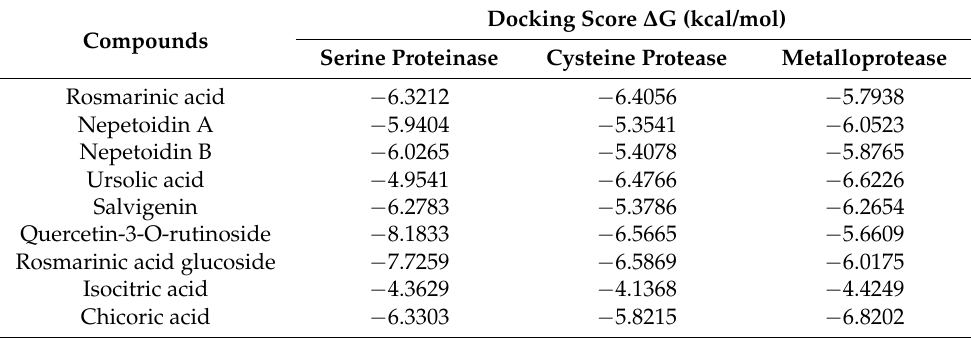
Table 4. Docking scores of compounds inside the active sites of serine proteinase (PDB:2F7O), metalloproteinase (PDB:1KAP), and cysteine proteinase (PDB:3IOQ). Docking Score ∆ G (kcal/mol) Compounds Serine Proteinase Cysteine